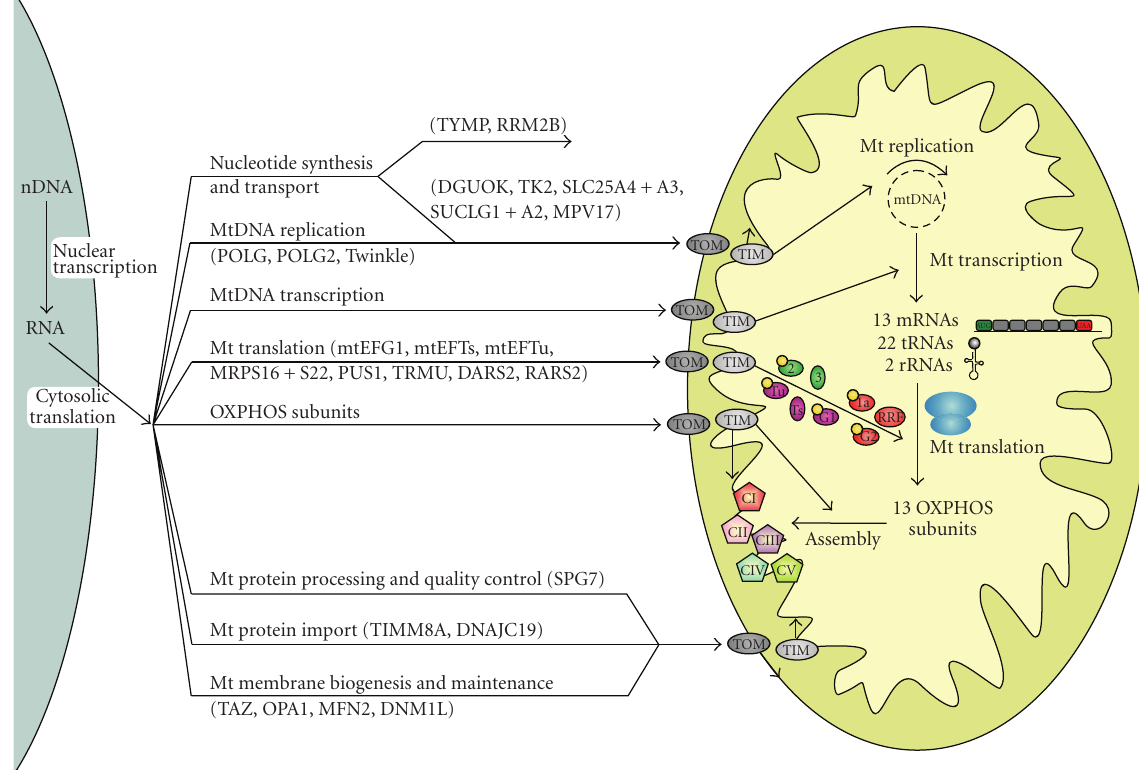
Figure 1: Schematic overview of the processes involved in mitochondrial translation and the biogenesis of the OXPHOS system. Before translation can take place in the mitochondrion, the mtDNA needs to be maintained, replicated and transcribed and numerous nDNA- encoded proteins have to be imported into the mitochondrion for these processes and for mitochondrial translation itself (see Figure 2 for more details on mitochondrial translation and its components depicted here). For the formation of the OXPHOS system, the nDNA- and mtDNA-encoded subunits need to be synthesized, imported, inserted into the inner membrane and assembled into enzyme complexes. The 13 mRNAs depicted refer to 9 monocistronic and 2 dicistronic transcripts. Proteins implicated in mitochondrial disorders are mentioned in brackets (also see Table 1). CI–CV = complex I–V of the OXPHOS system; TIM and TOM = translocase of the inner and outer mitochondrial